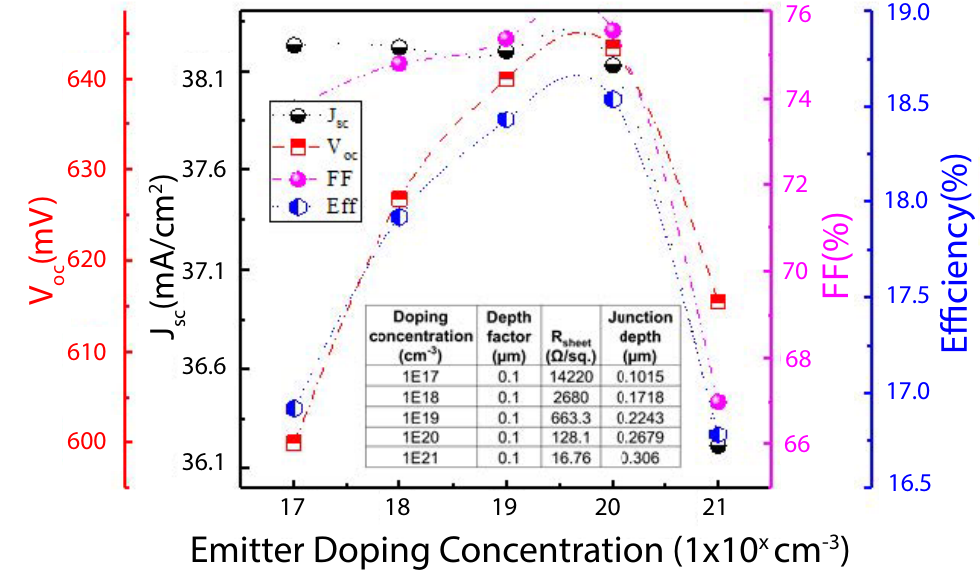
Figure 5. I–V characteristics as a function of emitter doping